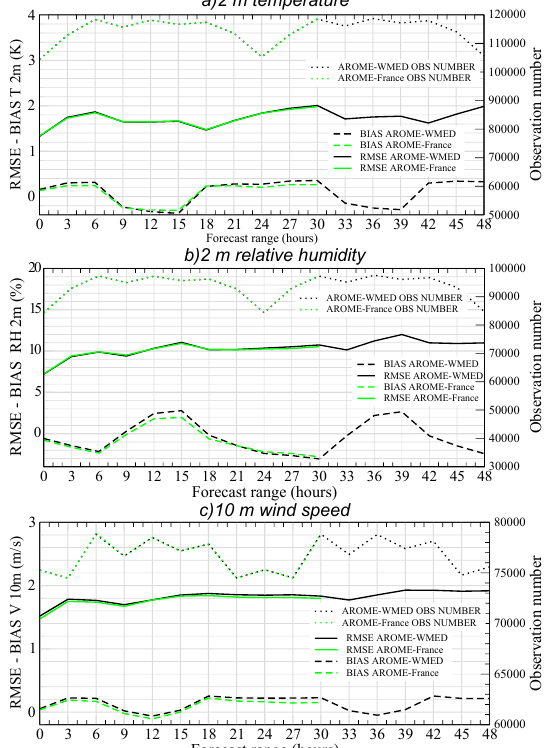
Figure 7. Bias (dashed lines) and root mean square error (solid lines) computed with 2m temperature (a) , 2m relative humidity (b) and 10m wind speed (c) with respect to the forecast range for the AROME-WMED model (black) and the AROME-France model (green) for SOP1 from 05 September to 06 November 2012. Dotted lines denote the number of observations used for the comparison (right y